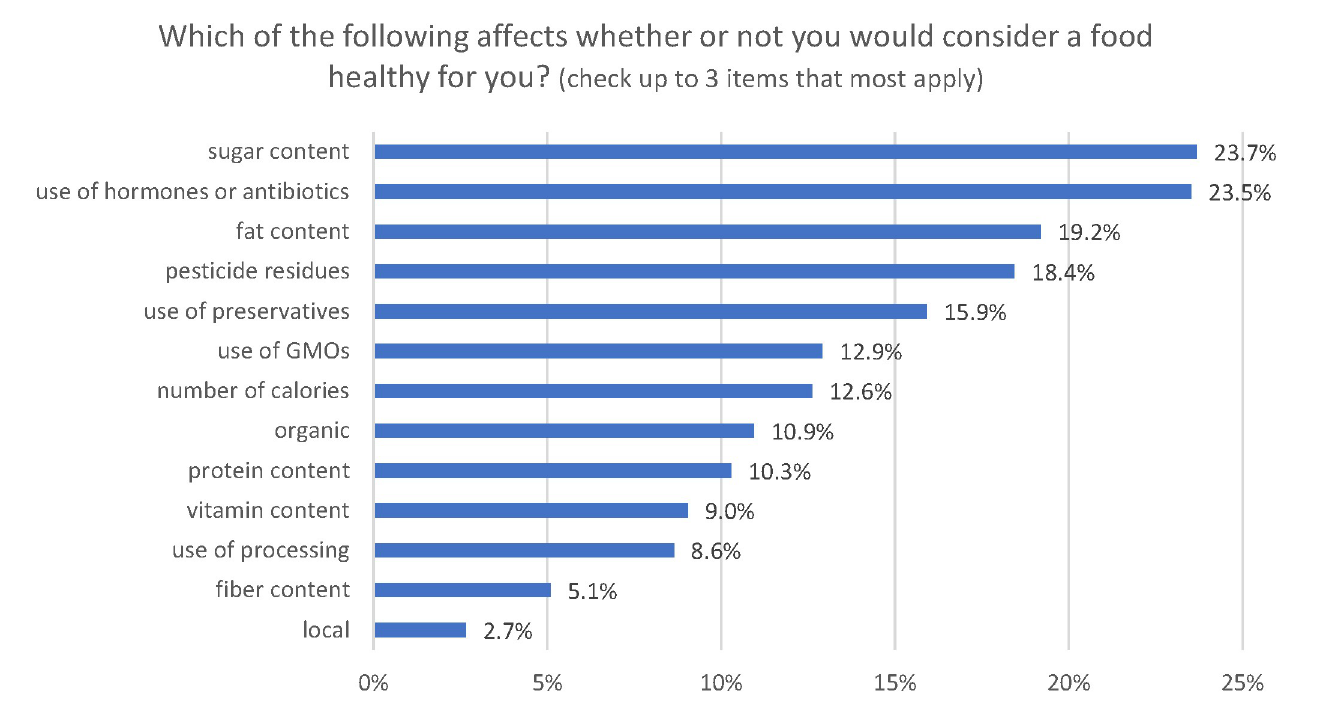
Fig 1. Factors affection consumers’ perceptions of a food’s healthiness ( sampling error for each statistic is ±2 . 7% . ) .